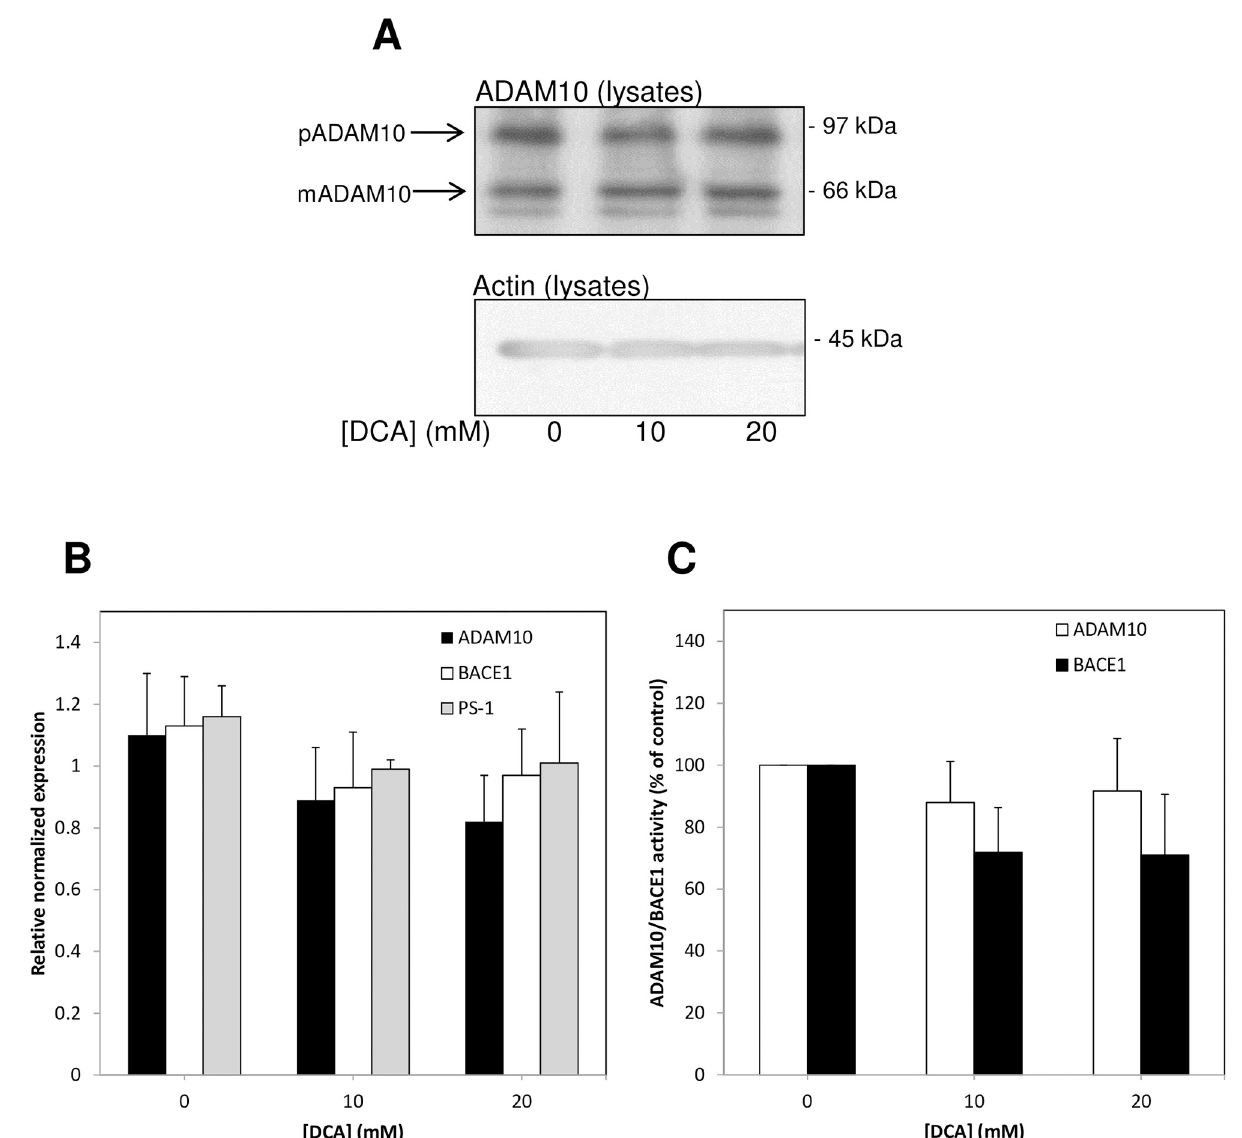
Fig 6. DCA does not alter secretase expression/activity in untransfected SH-SY5Y cells. Cells were grown to confluence before replacing the growth medium with UltraMEM containing the indicated DCA concentrations and culturing for an additional 24 h. Harvested cell pellets were split and used for protein and RNA extraction (Materials and methods). Parallel experiments were performed in which the resultant cell pellets were lysed and subjected to commercial fluorimetric assays for ADAM10 and BACE1 activity (see Materials and methods). (A) Equal amounts of protein from cell lysates were immunoblotted for ADAM10 and the blots were reprobed for actin. The positions of prodomain containing (pADAM) and mature, prodomain lacking (mADAM) forms of the enzyme are indicated. (B) Real-time qPCR was performed according to the Materials and methods section. Results are relative values normalized to RPLO and are means ± S.D. (n = 3). (C) ADAM10 and BACE1 activities in cell lysates. Results presented are non-substrate limited end-point assays determined following subtraction of ADAM10 and BACE1 inhibitor-treated control assay values (inhibitors were supplied as part of the commercial kits) and are corrected for protein levels before being expressed relative to control lysates prepared from cells incubated in the absence of DCA. Results are means ± S.D. (n =